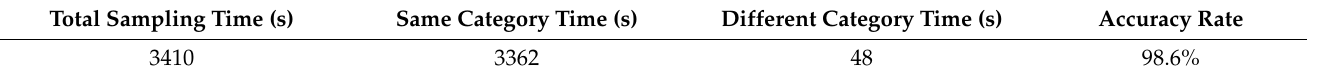
Figure 10. The error comparison of the past 10 s and the next 10 s. Table 5. The predicted category and real category comparison table.